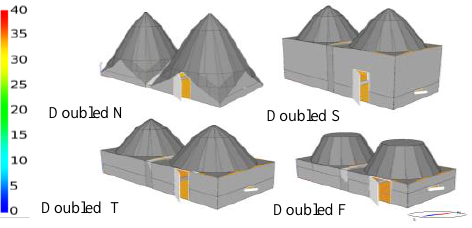
Figure 16. S3. (N, S, F, T) - Doubled domes models illustrating the operative temperature during the hottest day of the year (21 Jun) at